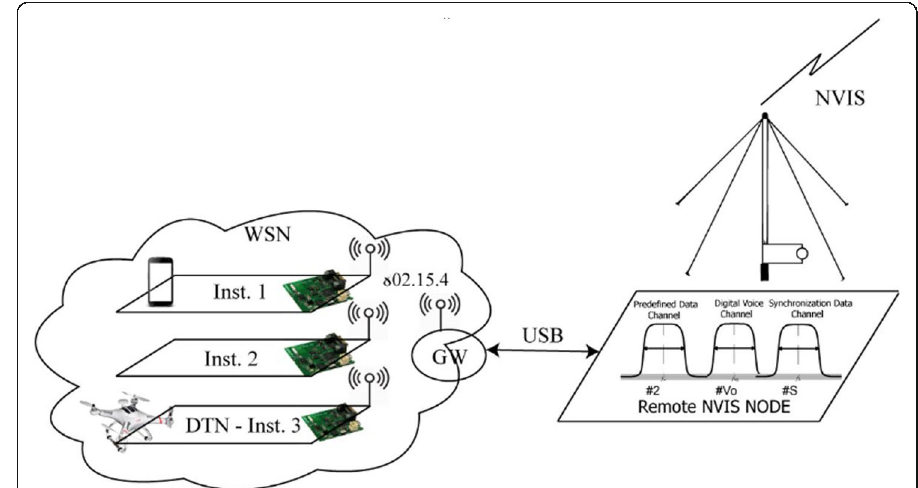
Fig. 18 WSN interface with NVIS node. Protocol and connectivity chosen to transmit sensors ’ data to the NVIS remote node, and then to the central